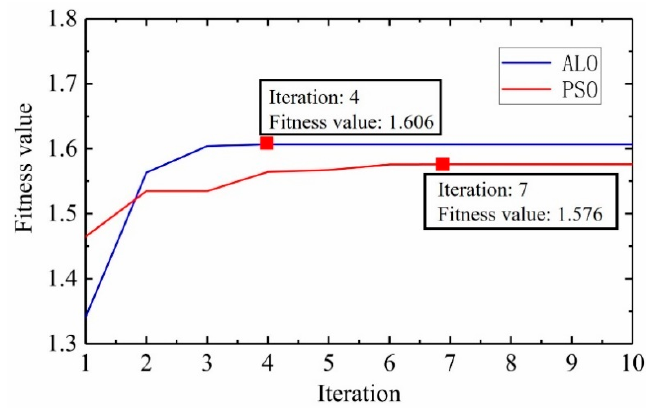
Figure 19. The convergence curve of ant lion optimization (ALO) and particle swarm optimization (PSO). Table 3. Comparison of optimization performance between ant lion optimization (ALO) and particle swarm optimization (PSO).